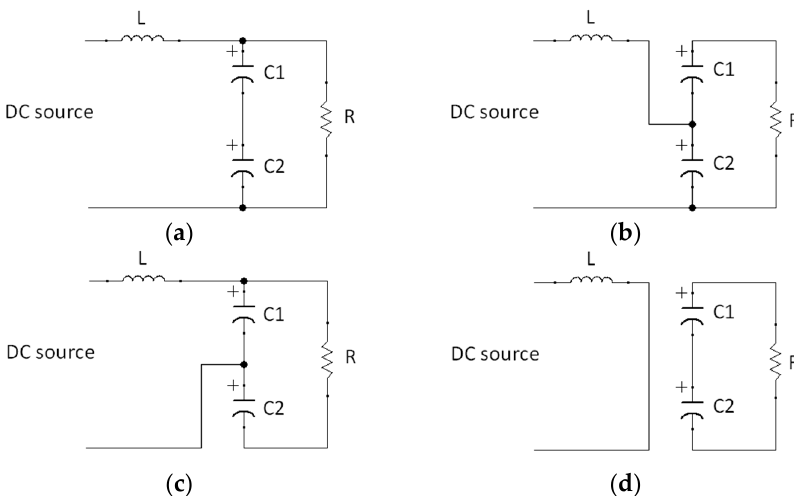
Figure 3. TLBDC equivalent electrical schemes for control signals u 1 (t)-u 2 (t) sequence: ( a ) 0-0, ( b ) 1-0, ( c ) 0-1 and ( d ) 1-1.